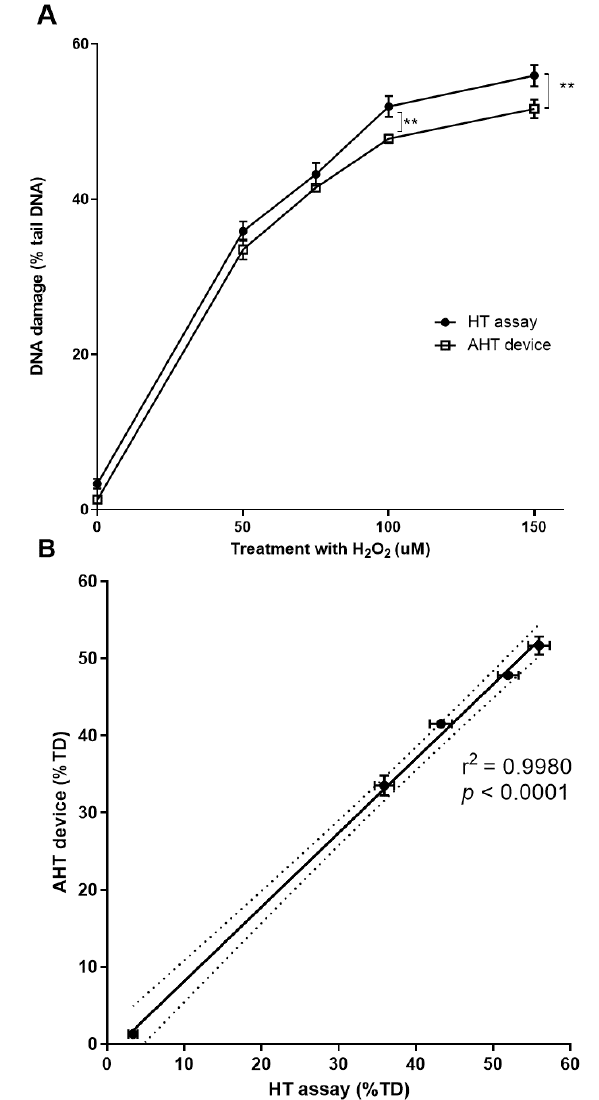
Figure 3. Comparison of the dose-response obtained using the HT and AHT approaches. HaCaTs were treated with 0, 50, 75, 100, and 150 μM H 2 O 2 in duplicate, and a comet assay was performed using both HT assay and AHT device in parallel, using the same stocks of all buffers and performed on the same day. All comets, arising from both the HT assay and AHT device, were analyzed using Comet assay IV software (perceptive instruments, Bury St Edmunds, UK). Error bars represent the mean ± SEM of 100 individual determinations. ( A ) Dose-response following H 2 O 2 treatment in samples run using either the HT (filled round symbols) or AHT (square open symbols) approach. ** represents p < 0.05 ( B ) Correlation of the % tail DNA of samples run using HT assay (x-axis) vs. the AHT device (y-axis). A line of best fit (solid line) was obtained using linear regression analysis using GraphPad Prism. R 2 = 0.998. The range between the two dotted lines represents the corresponding 95% confidence intervals. Horizontal and vertical error bars represent the mean ± SEM of 100 individual determinations from the AHT system and HT assay,